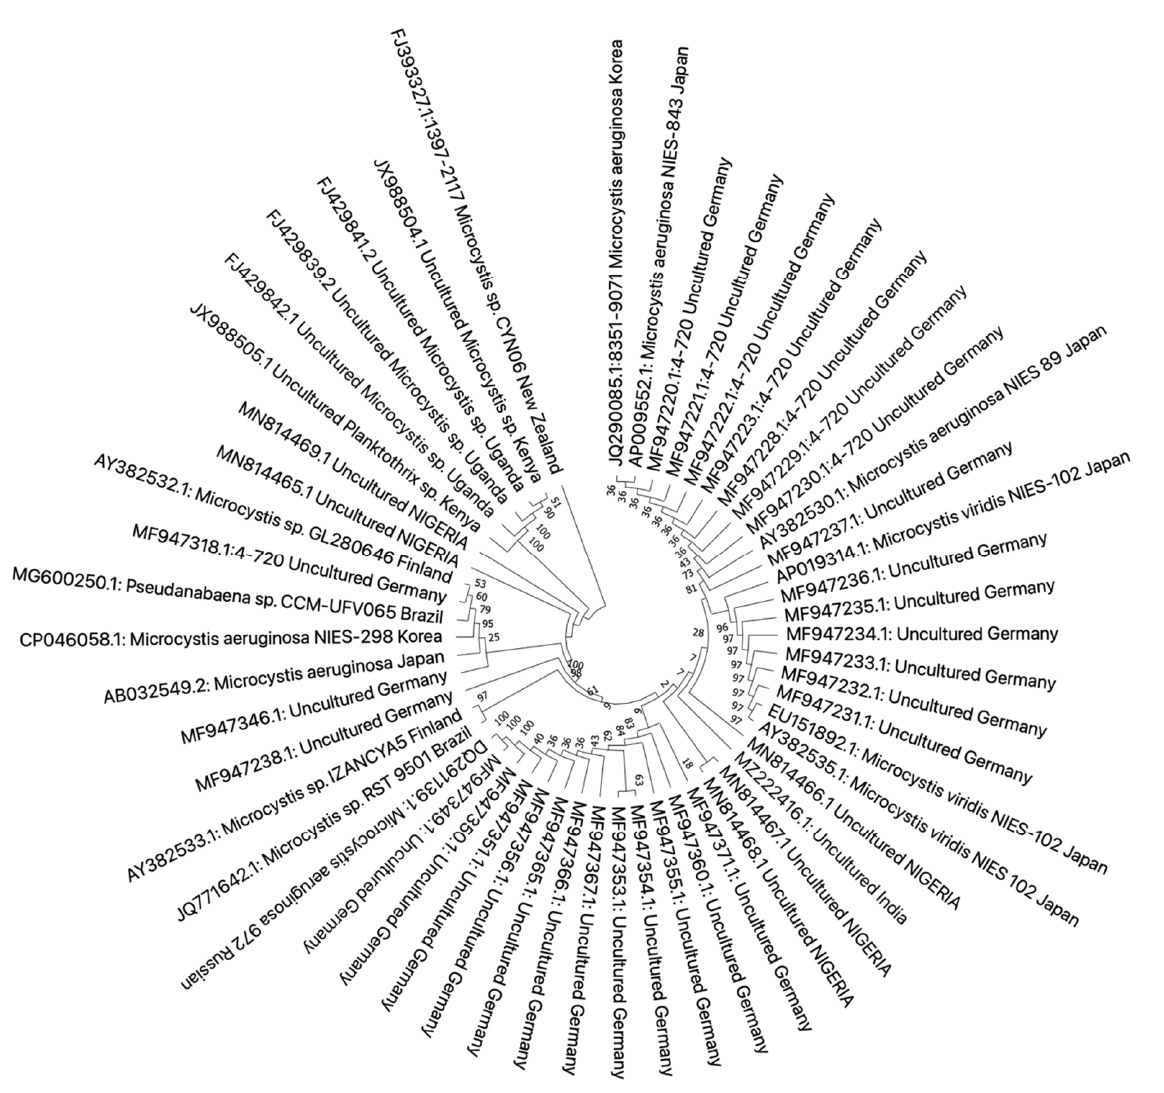
Figure 5. UPGMA phylogenetic tree of the mcy E gene of blooms and isolated cyanobacteria from Africa and other continents. The bootstrap consensus tree was inferred from 1000 replicates, and the evolutionary distances were computed using the maximum composite likelihood method. The analysis involved 54 nucleotide sequences. All ambiguous positions were removed for each sequence pair (pairwise deletion option). There was a total of 847 bp in the final dataset. Evolutionary analyses were conducted in MEGA X version 11 for macOS.